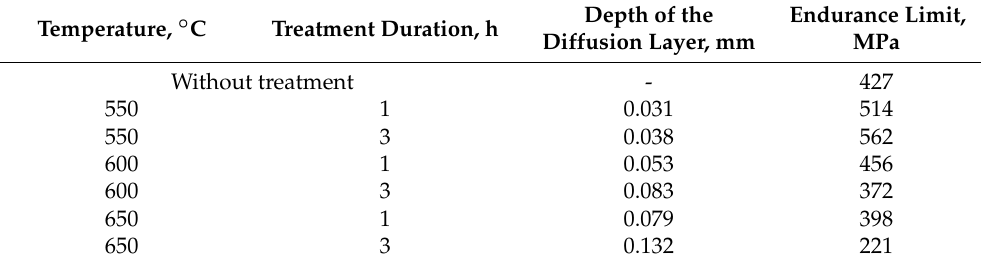
Table 5. Dependence of fatigue strength on nitrocarburizing modes for steel 60Si2Cr. Temperature, ◦ C Treatment Duration,